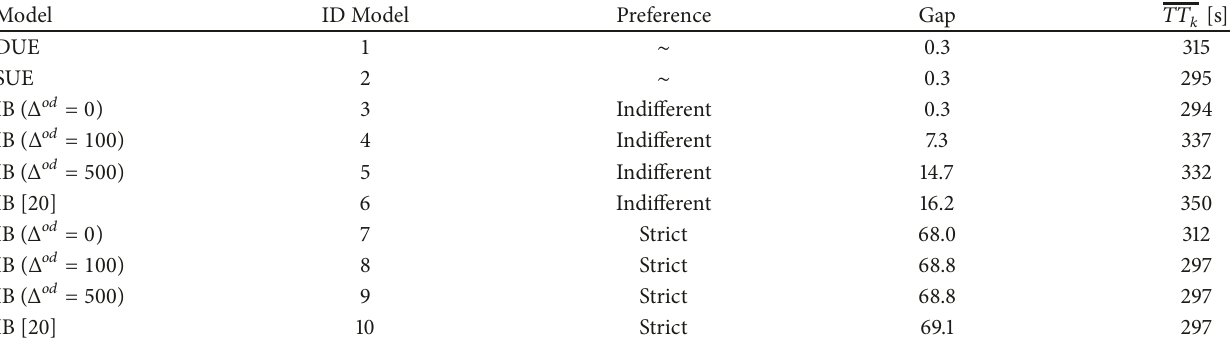
Table 5: The Gap value and the average travel times per route 𝑇𝑇 𝑘 [ in s ] calculated from the distributions shown in Figure 6 are also listed. These values are listed for the DUE, SUE, and different settings of the indifference